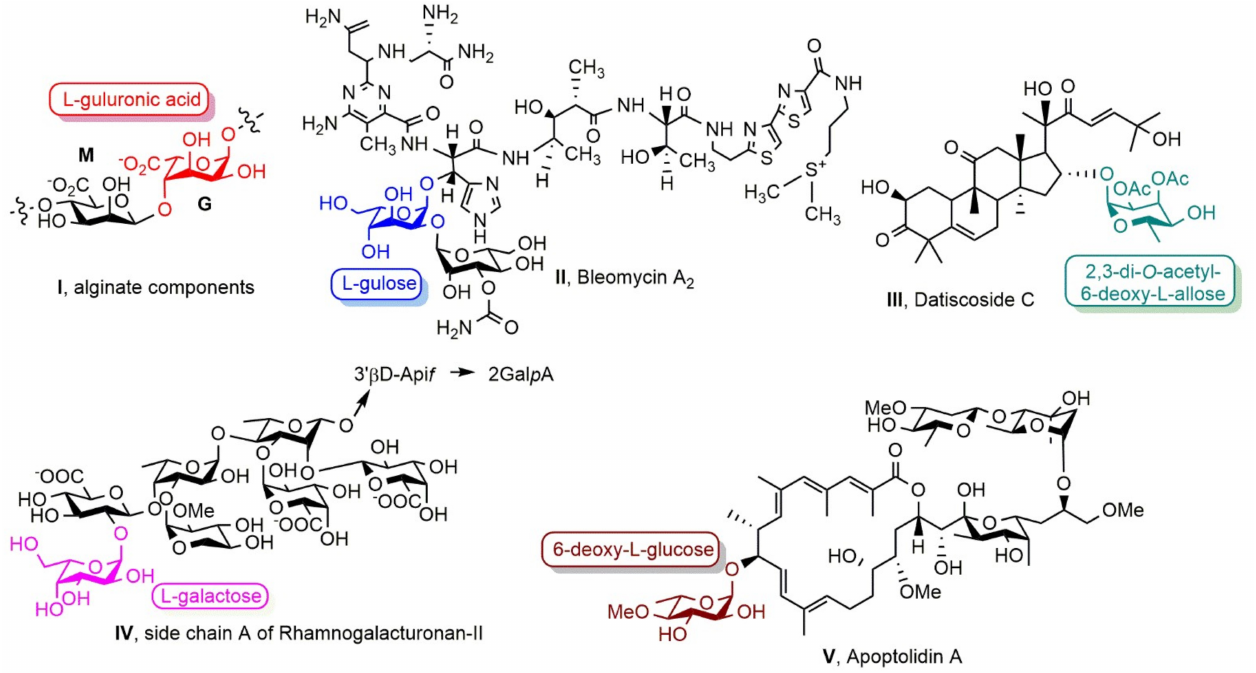
Figure 1. Structure of some L -hexose containing natural